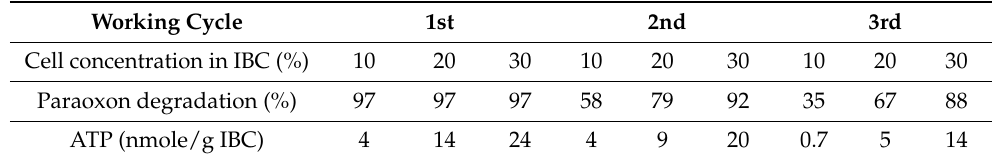
Table 4. Degradation of paraoxon (0.15 mM) and changings of intracellular ATP concentration in bac- terial cells participating in artificial immobilized consortium functioning in multiple working cycles. Working Cycle 1st 2nd 3rd Cell concentration in IBC (%) 10 Paraoxon degradation